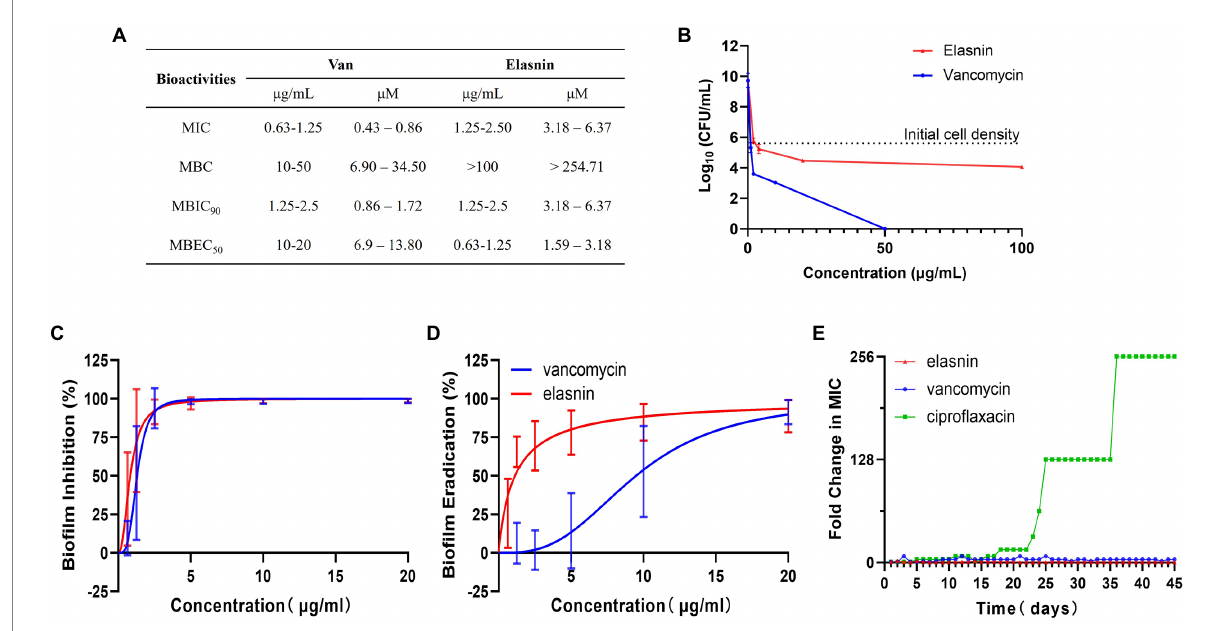
FIGURE 1 Bioactivities and resistance-development study of elasnin against MRSA. (A) Summary of MICs, MBCs, MBICs and MBECs of MRSA towards vancomycin and elasnin. (B) Cell viability of MRSA after 24 h of treatment with various concentrations of elasnin and vancomycin ( n = 3). (C) Minimum concentration needed to inhibit 90% of biofilm formation ( n = 12, average ± standard deviation). (D) Minimum concentration needed to eradicate 50% of pre-formed biofilms ( n = 12, average ± standard deviation). (E) Fold change in MICs towards elasnin, vancomycin and ciprofloxacin after 45-days of exposure under sub-inhibitory concentrations (0.5 × MIC) of the respective antimicrobials ( n =